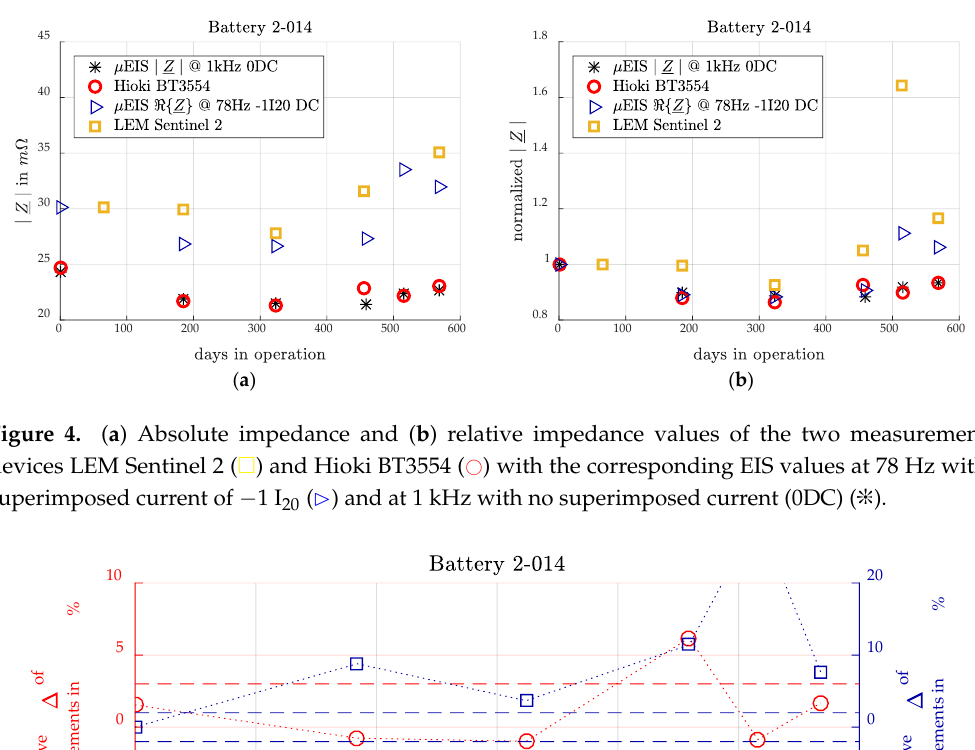
Figure 5. Relative deviation between commercial measurement devices and the corresponding EIS measurements with the commercial measurement as base. Left axis: 1 kHz impedance comparison ( ○ ). Right axis: ~70 Hz impedance comparison ( □ ).